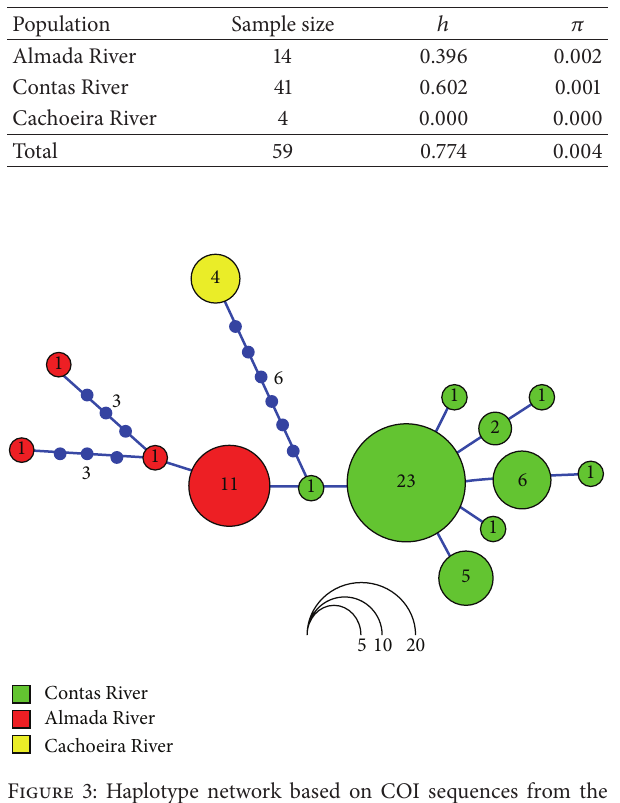
Table 5: Haplotype ( ℎ ) and nucleotide ( 𝜋 ) diversity in COI sequences within populations of Lignobrycon myersi .